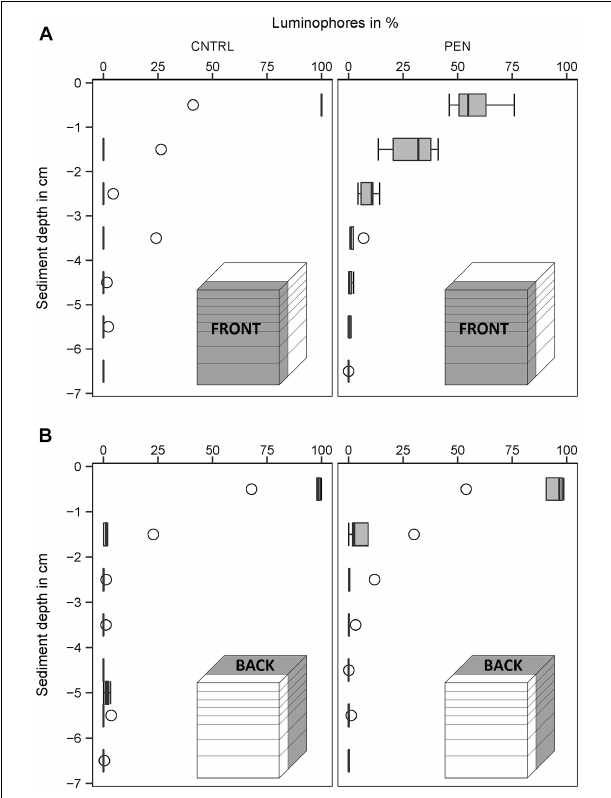
FIGURE 10 | Luminophore distribution (%) as a function of sediment depth (cm) in the fine sand experiments with sand-like luminophores. (A) front close to the plate for the CNTRL and PEN treatment. (B) Toward the back of the sediment for the CNTRL and PEN treatment. The box of the boxplot represents the interquartile range, the median is indicated by a line within the box. Whiskers indicate variability outside the interquartile range and circles indicate outliers.